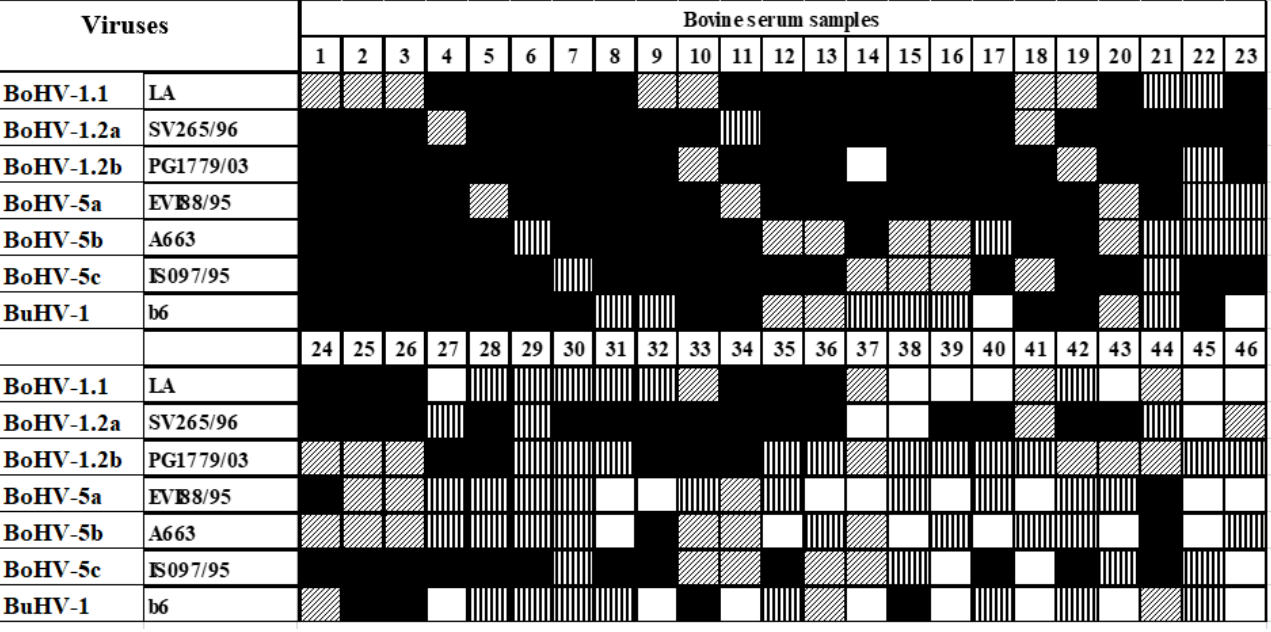
Table 2. Comparison between serum neutralization (SN) and sAgELISAs for detection of antibodies to alphaherpesviruses in bovine sera (n = 600).